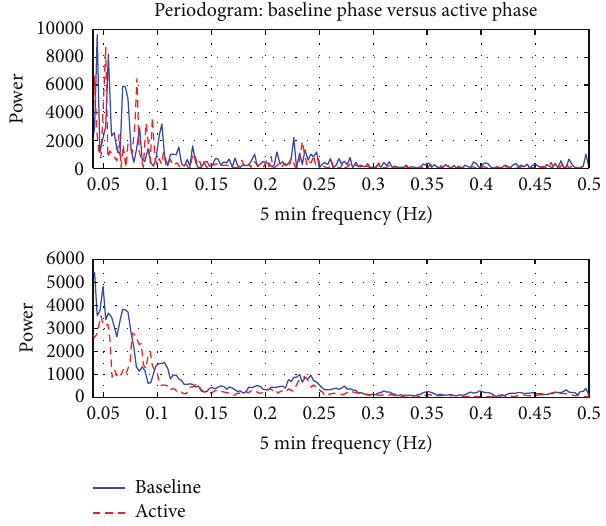
Figure 8: Power spectrum. Note: sampling rate of the ECG was 1Hz, so the frequency spectrum was plotted until 0.5 HZ (Nyquist frequency criteria). There is an increment of the power around 0.05 and 0.1Hz during the stimulation using 10Hz and 5 repetitions.